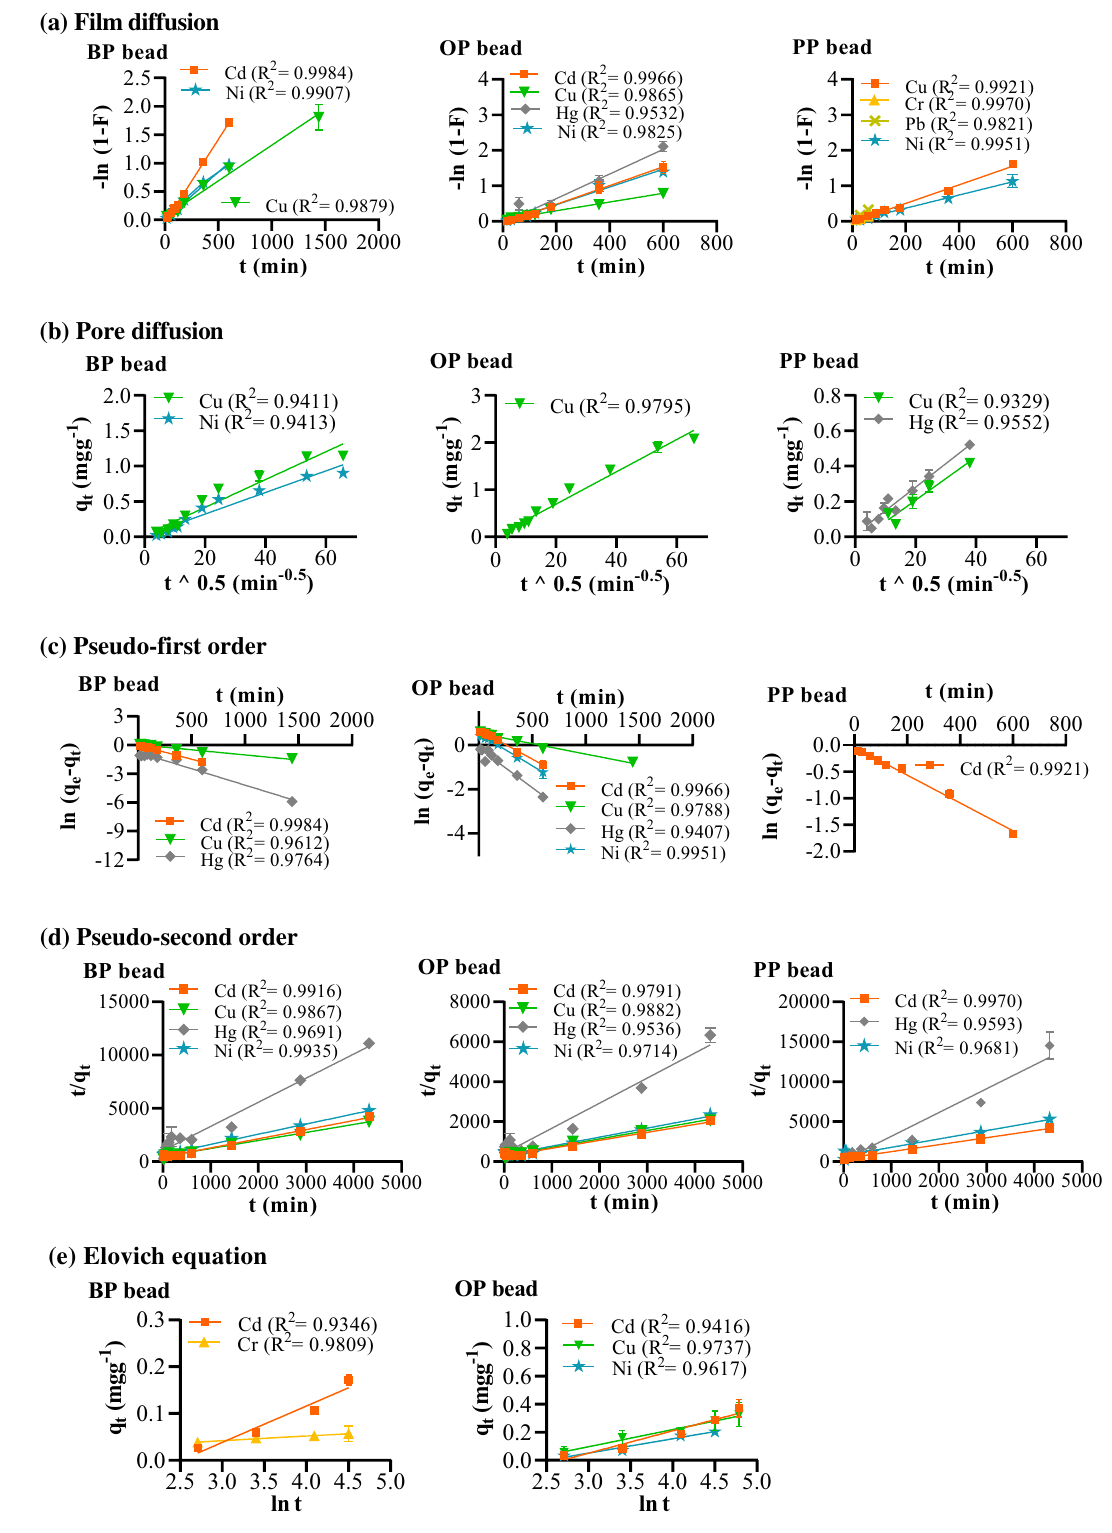
Fig. 6 Biosorption kinetic models. One bead was incubated in a The points represent mean ± SE for N = 3 with data analysis by lin- ear regression. Only ions with an R 2 > 0.93 are shown. a FD, b PD,